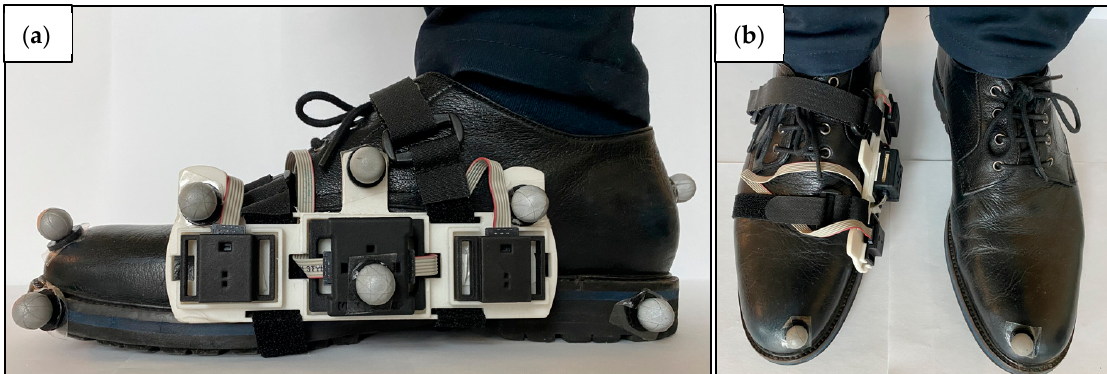
Figure 11. Experimental setup. ( a ) The wearable sensors are attached on a rigid support fixed on the medial side of the right shoe. All retro-reflective markers used, including the virtual ones, are shown. The customized rigid support is optimized to minimize the volume of the wearable system and to host a central MIMU, two lateral distance sensors, and three markers in the upper parts. ( b ) Complete con fi guration of the experimental setup showing only the markers used for walking trials.